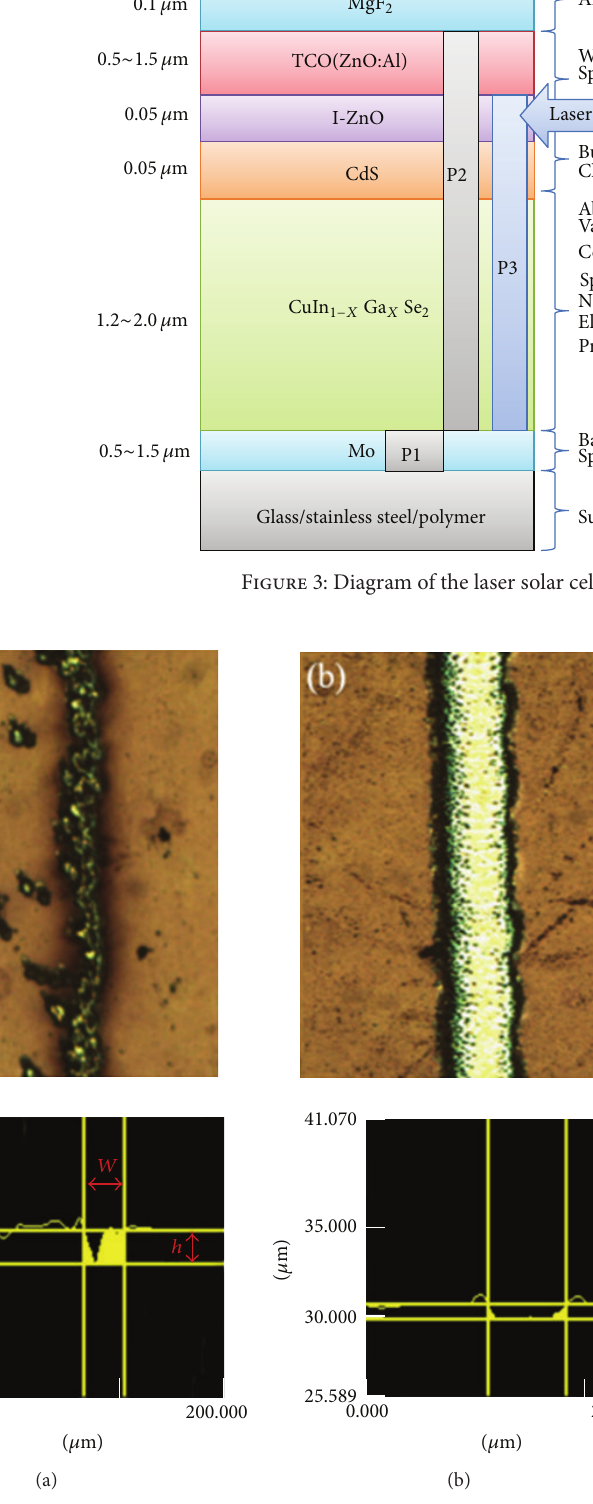
Figure 4: UV laser focus position. (a) Perpendicularity, (b) minus leave perpendicularity, and (c) positive leave